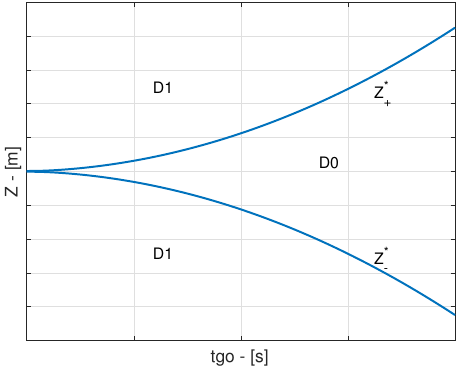
Figure 2. A pursuit-evasion game